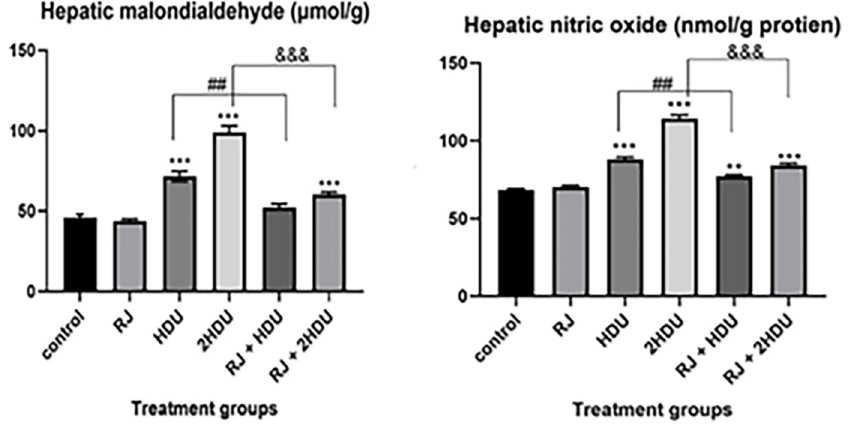
Fig 4. Effects of oral royal jelly (RJ; 100 mg/kg bwt) administration on the biomarkers of oxidative damage, malondialdehyde (MDA), and nitric oxide (NO) formation in rats treated with hydroxyurea (HDU; 225 or 450 mg/kg bwt) for 60 days. Data are presented as the mean ± SEM. Compared to the control, significance at (p < 0.01) �� and (p < 0.001) ��� (ANOVA with Dunnett’s multiple comparison test). Compared to HDU treated groups using Unpaired t-test, significance at p < 0.01 ## and p < 0.001 &&& for HDU and 2HDU groups, respectively).